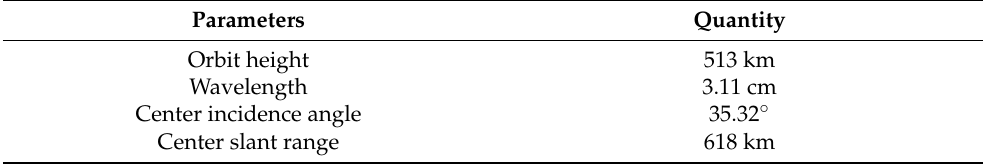
Table 4. The parameters of the TerraSAR-X data.